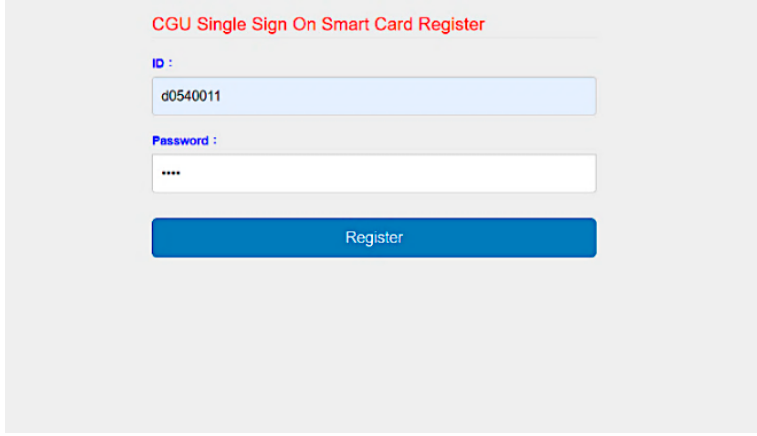
Figure 13. Smartcard.